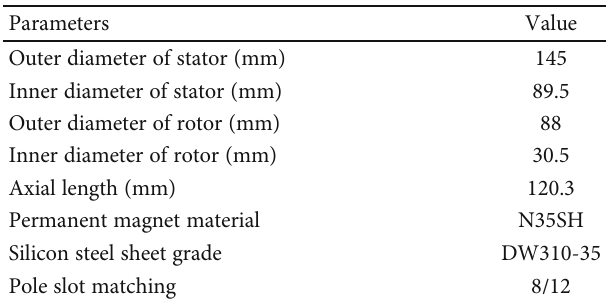
Figure 1: PMSM structure of asymmetric poles. Table 1: Motor structure parameters.